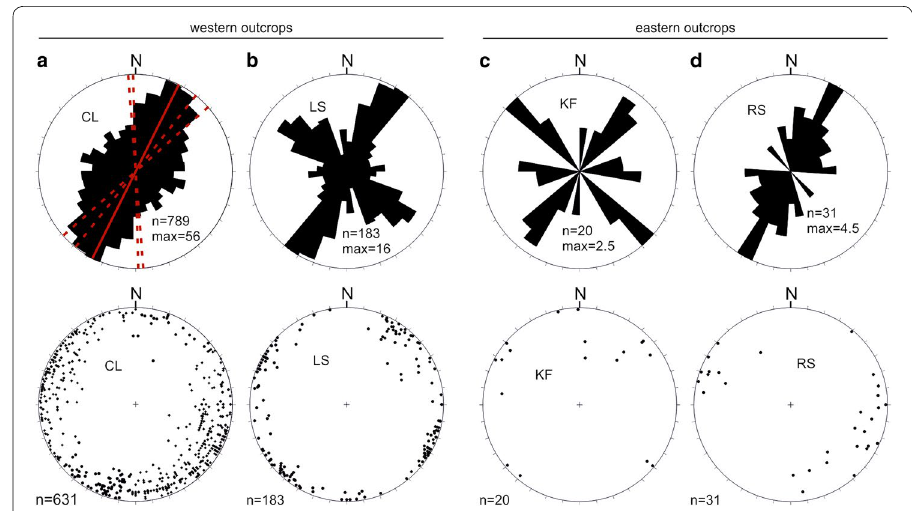
Fig. 6 Fracture orientation data shown in equal area‑scaled rose diagrams with 10° bin size and in pole plots (equal area, lower hemisphere). a Cleebourg (CL) fracture orientation data with the strike of the main fault (bold line) and minor faults (dashed lines) marked, b Leistadt (LS), c Kammerforster (KF), and d Riesenstein (RS)